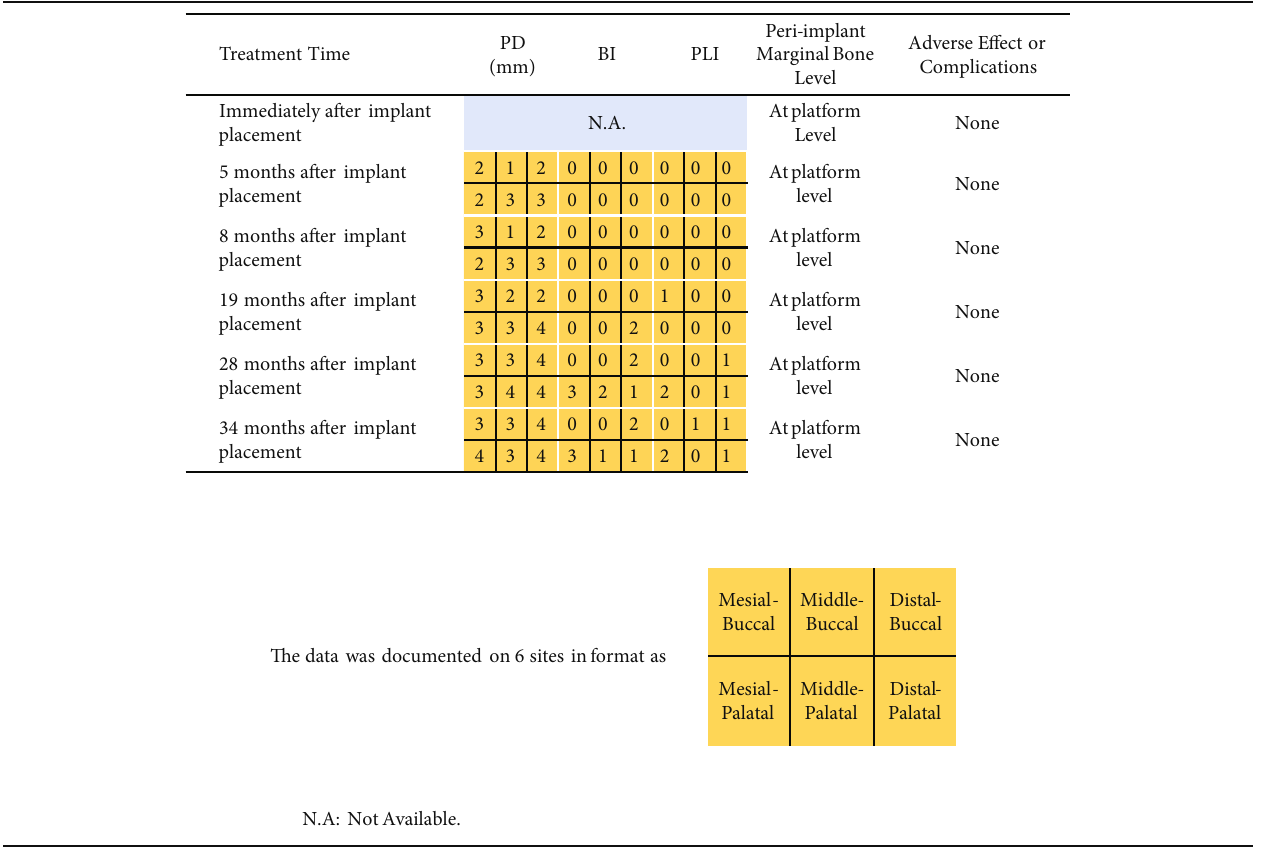
Figure 9: Visual analog scales (VAS) for discomfort were distributed to patient at 6 months after MSFE and immediately after crown placement. Table 2: Clinical evaluation of tooth #26 at each